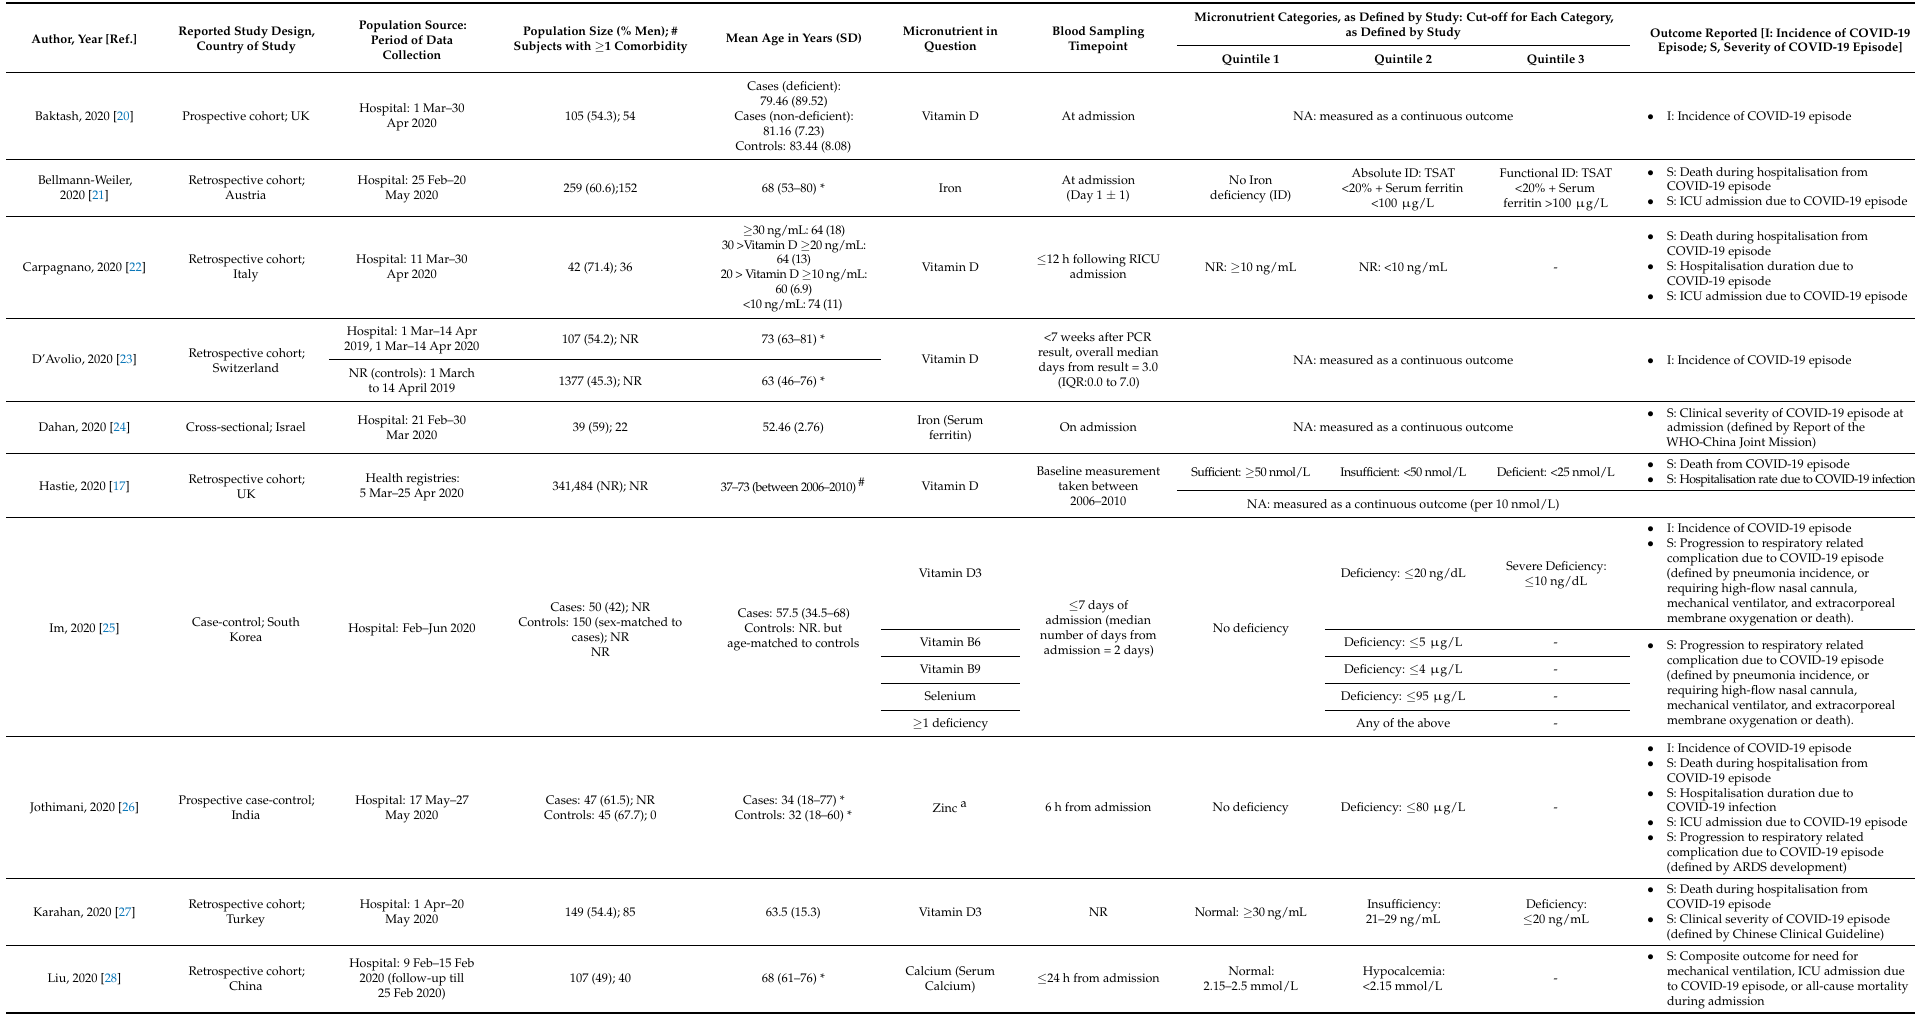
Table 1. Studies assessing the micronutrient deficiency on